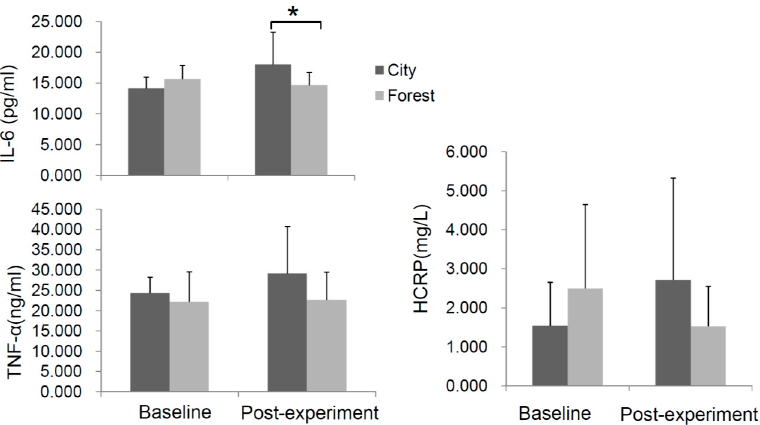
Figure 5. Effect of forest bathing on serum levels of pro-inflammatory indicators. Interleukin-6 (IL-6), tumor necrosis factor α (TNF- α ), and C-reactive protein (CRP) of subjects were evaluated before and after the experiment in the forest bathing group ( n = 23) as well as in the urban control group ( n = 10). * p < 0.05, analyzed by the Kruskal-Wallis test followed by the Dunn-Bonferroni test.